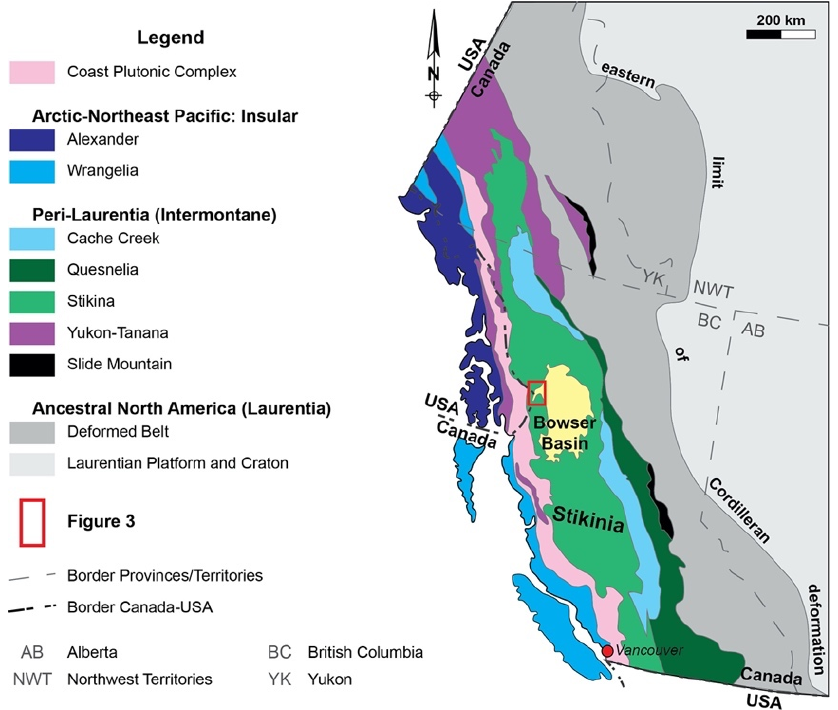
Figure 1. Simplified geological map of the Canadian Cordillera [8,9]. The Paleozoic Stikine assemblage is not well exposed in Stikinia; it forms, however, the basement for younger arc-related strata [12]. The Upper Triassic Stuhini Group consists of several units that are not well defined stratigraphically due to difficulties to correlate these units continuously and the occurrence of similar lithological units at different stratigraphic levels (Figure 2; [8,12]). The units formed in marine environments based on fauna in sedimentary rocks [19]. The Hazelton Group lies unconformably to disconformable above the Stuhini Group, and has an Early to Middle Jurassic age (Figure 2; [4,6,12,28,30,31]), although an age as old as Upper Triassic has been postulated by Nelson et al. [8].